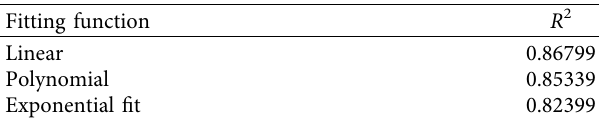
Figure 7: Relationship between W and moisture content. ET Table 3: Fitting functions and their related R 2 for determining the best relation between W and moisture content. ET